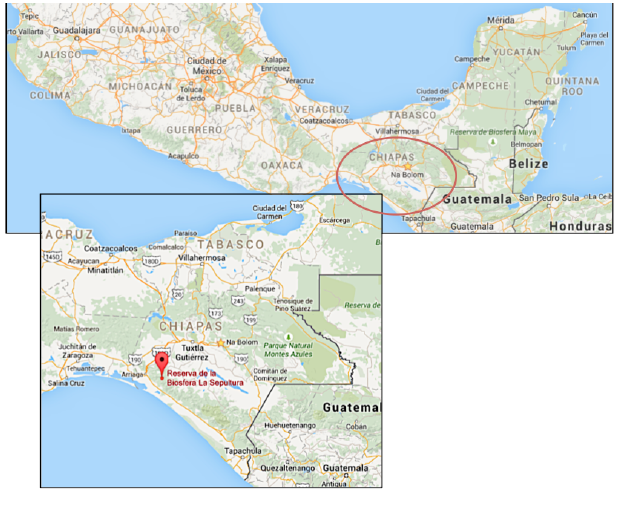
Fig. 1 . Location of La Sepultura Man and Biosphere Reserve, Chiapas, Mexico. Source: